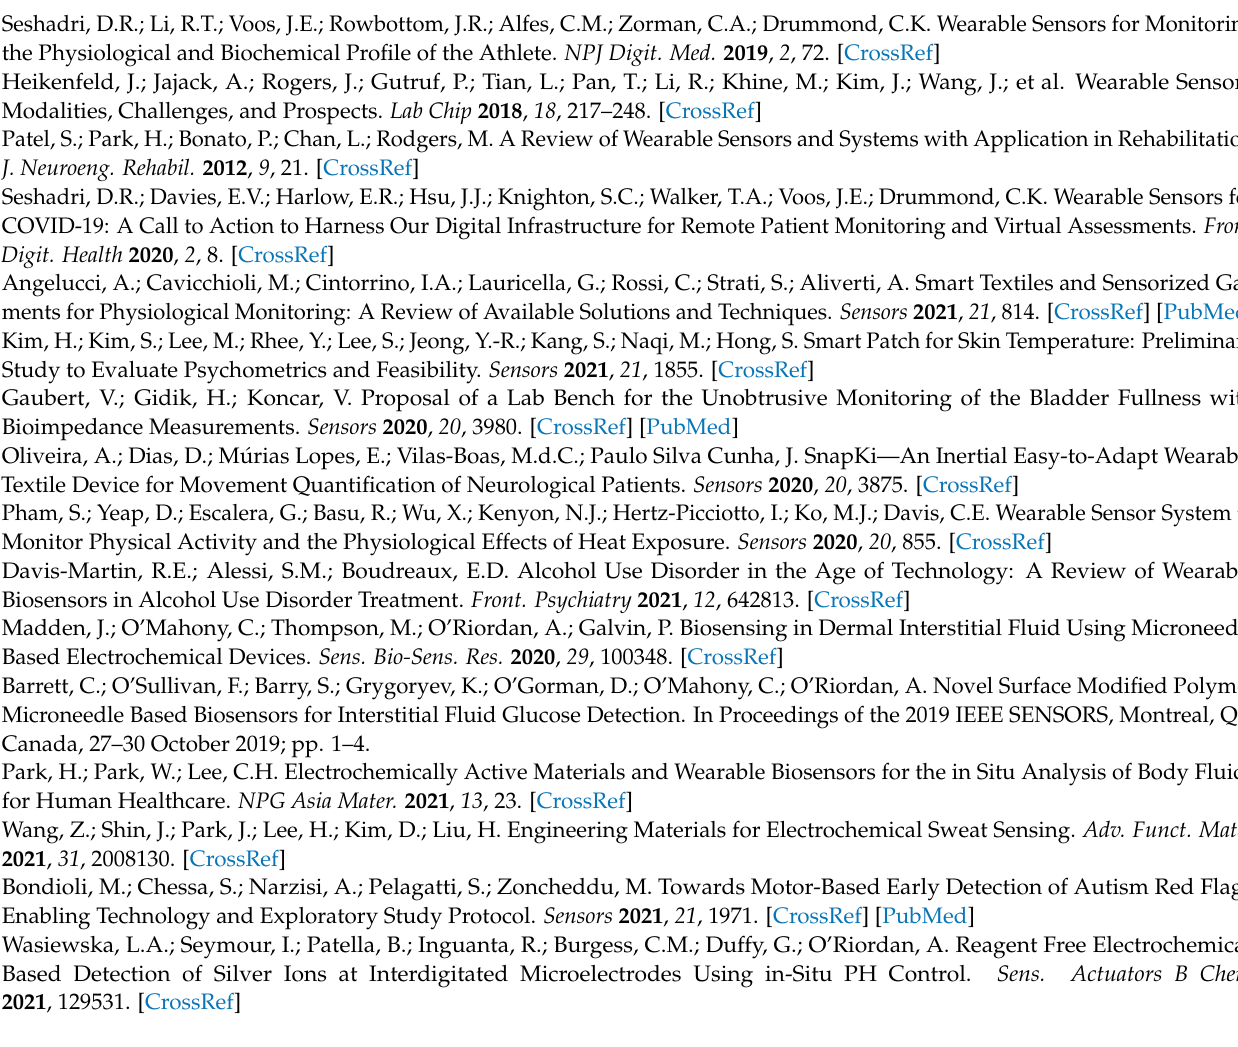
Figure S2: Growth curve for the electrochemical deposition of PANI on ITO-PET/rGO substrate; Figure S3: Measurement of the pH of a real sweat sample using a laboratory pH